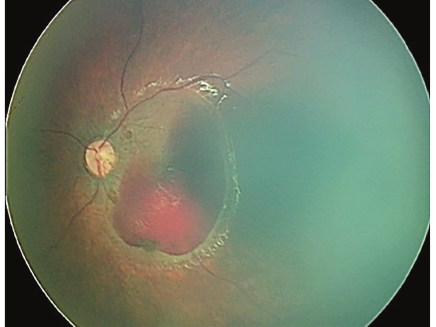
Figure 2: Retinography of the same eye (OS) after 30 days of follow- up. Note the spontaneous decrease in blood